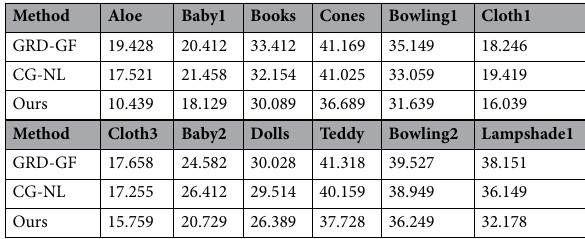
Table 4. Mismatching rate of all pixel disparity for different stereo matching